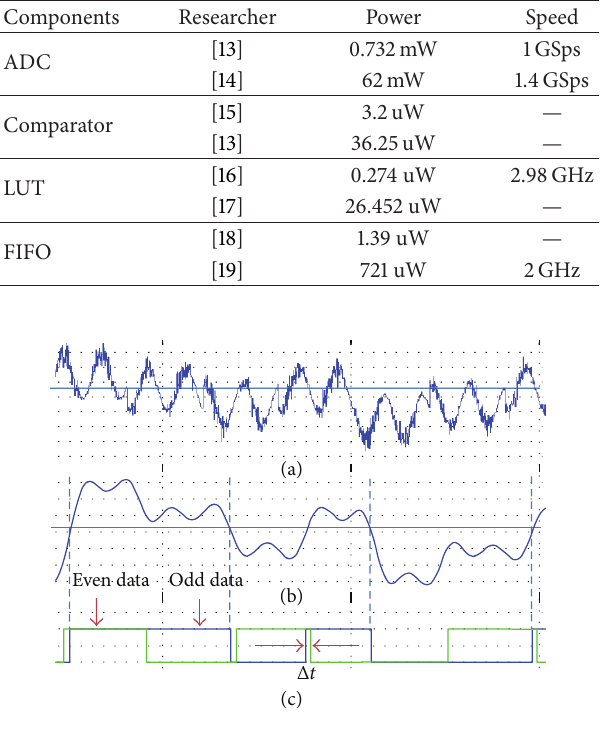
Figure 7: (a) Output from mixer of QPSK and sine carrier, (b) filtered I-channel signal with LPF, and (c) showing the mismatch in time domain between even and odd data due to phase error in sine